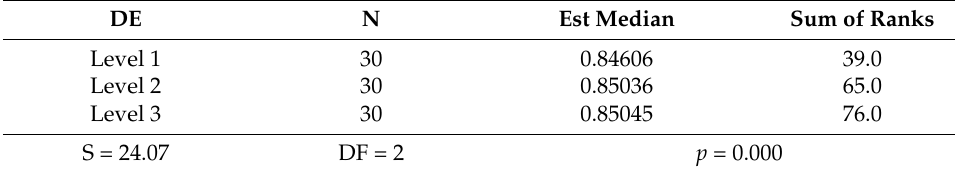
Figure 6. Normality test for winter. Table 14. Friedman’s test, winter—DE blocked by SSO.